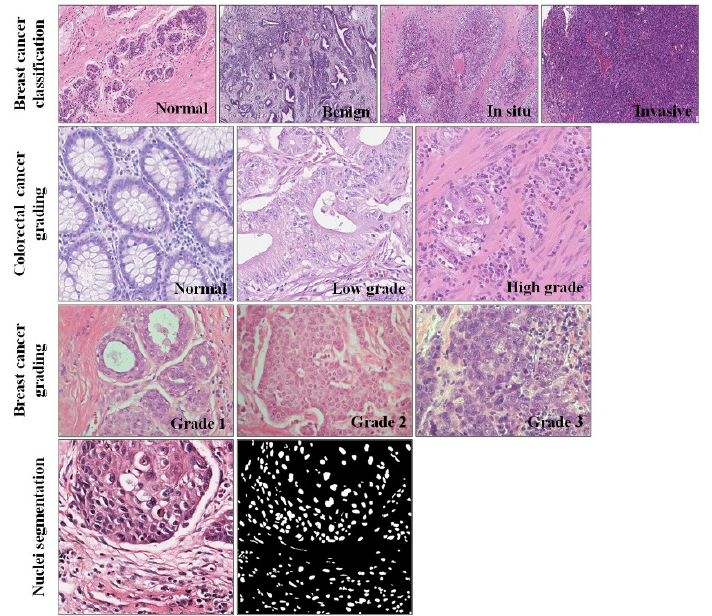
Figure 4. Examples of the four datasets used in the experiments.